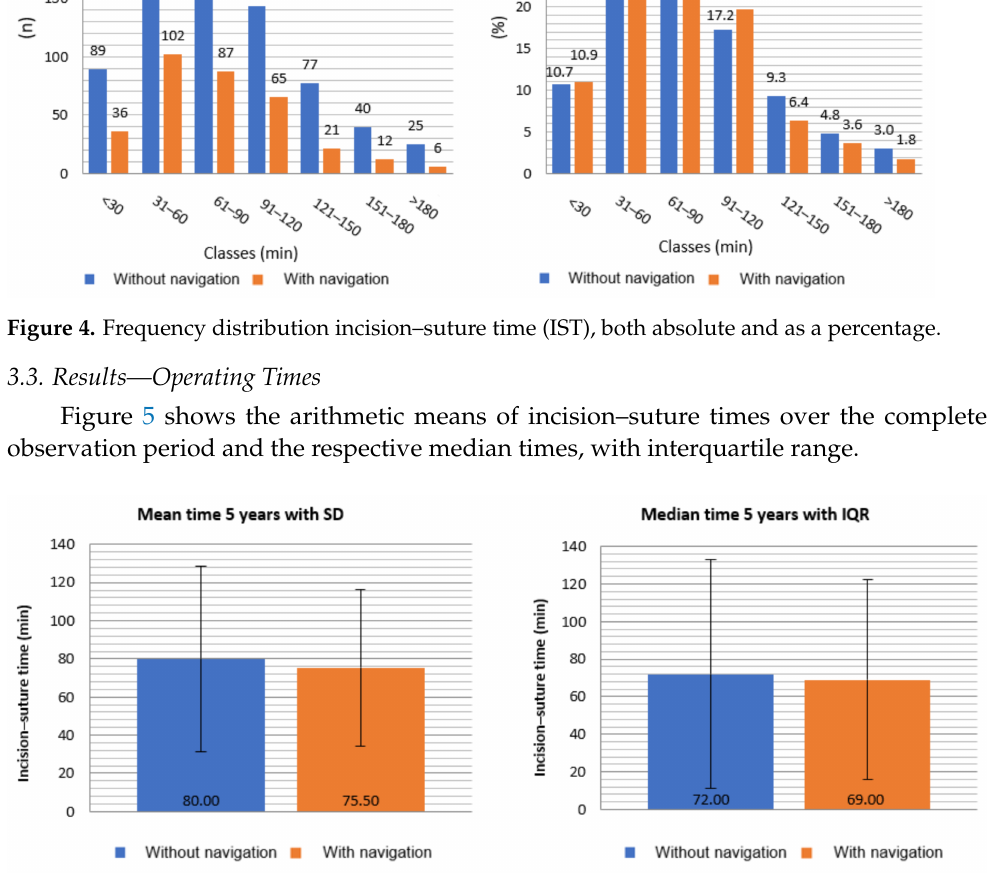
Figure 5. Mean durations over 5 years, with standard deviation (SD) and interquartile range (IQR). For operations without navigation, the overall mean time is 80 min, with a standard device are a mean of 4.5 min shorter, hence, lasting 75.5 min, with a standard